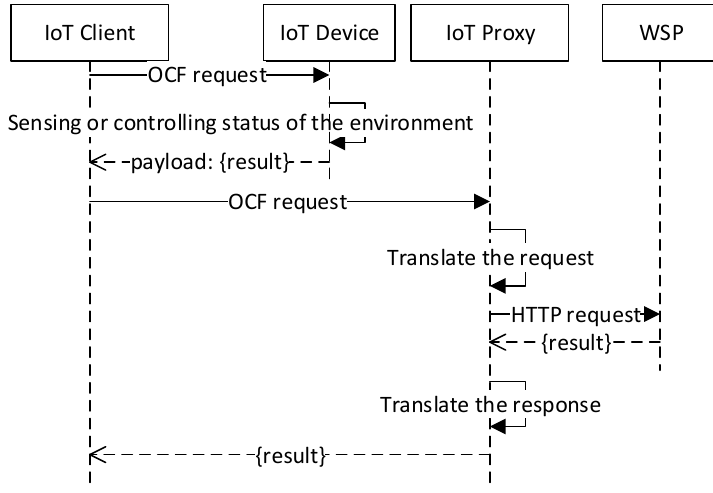
Figure 9. Transparent access to services of IoT device and WSP.